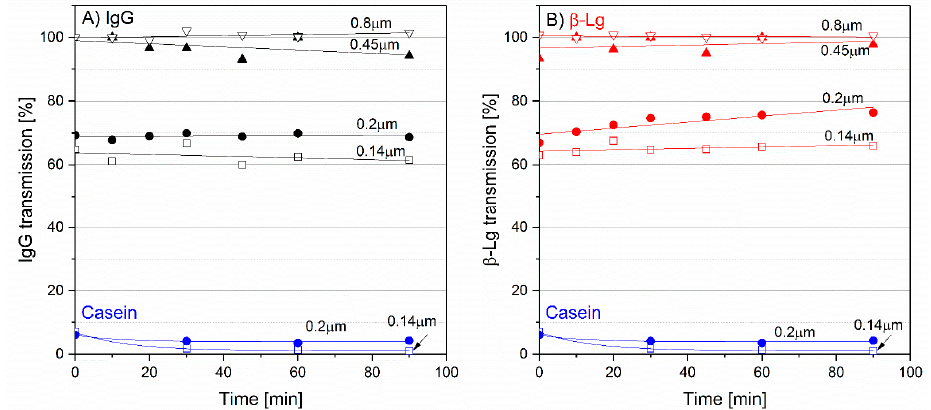
Figure 1. IgG (black) and casein(blue) ( A ) and β -Lg (red) and casein (blue) ( B ) transmission as a function of time at a pore size of 0.14 µm ( □ ) belonging illustrated by the arrow), 0.2 µm ( ● ), 0.45 µm ( ▲ ), 0.8 µm ( Δ ) (gradient membrane, 50 °C). For casein transmission of 0.45 µm and 0.8 µm membranes, see the Supplementary Material.